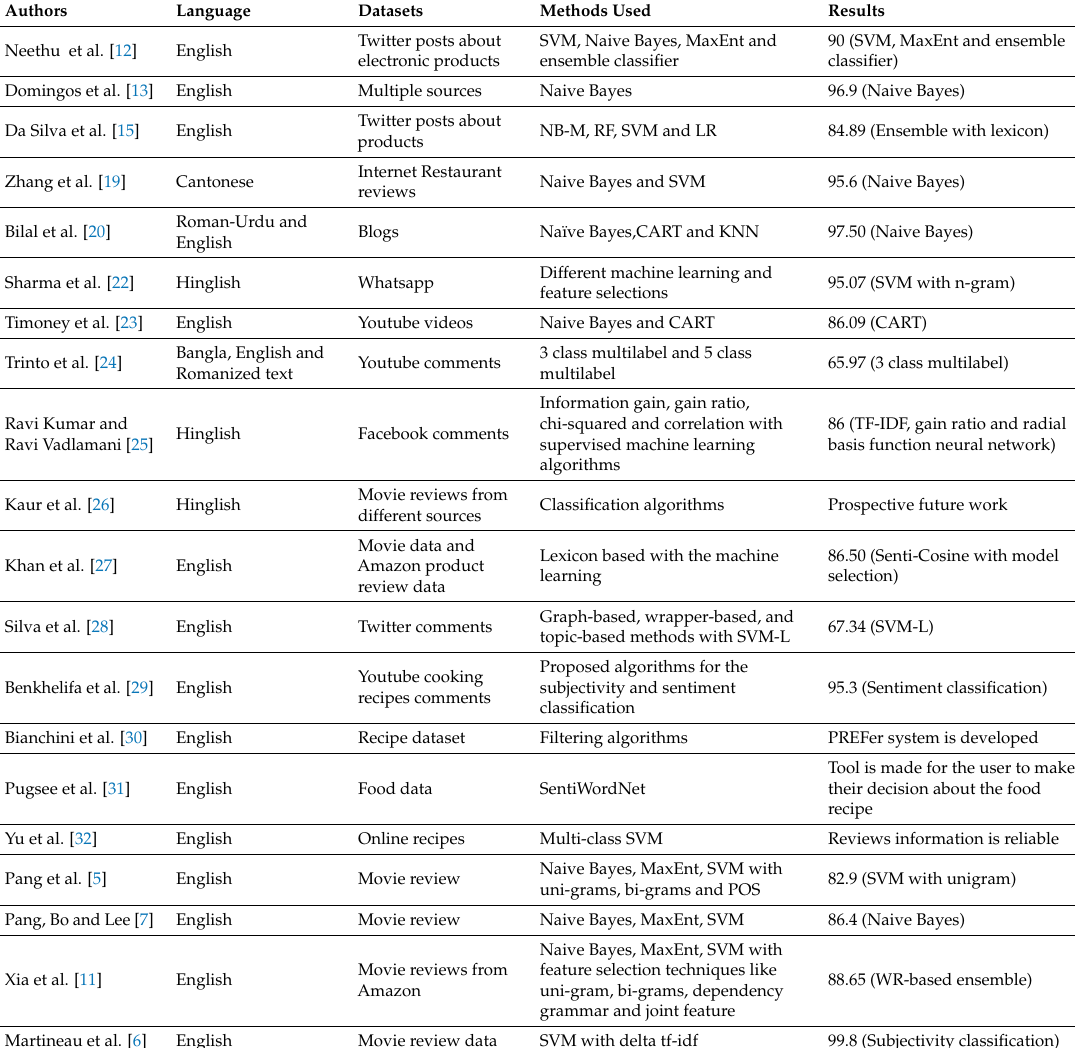
Table 1. Literature survey